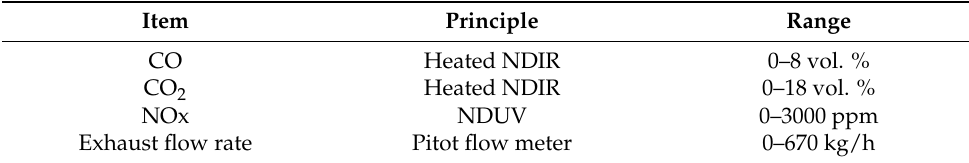
Table 2. Specifications of PEMS.